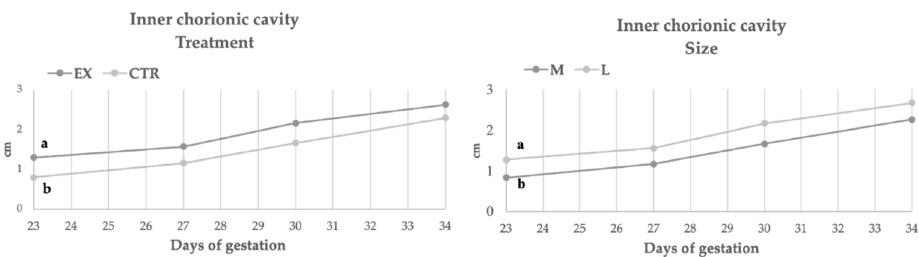
Figure 2. Inner chorionic cavity during gestation in function of diets and size. EX: experimental group CTR: control group; a, b: p < 0.05.